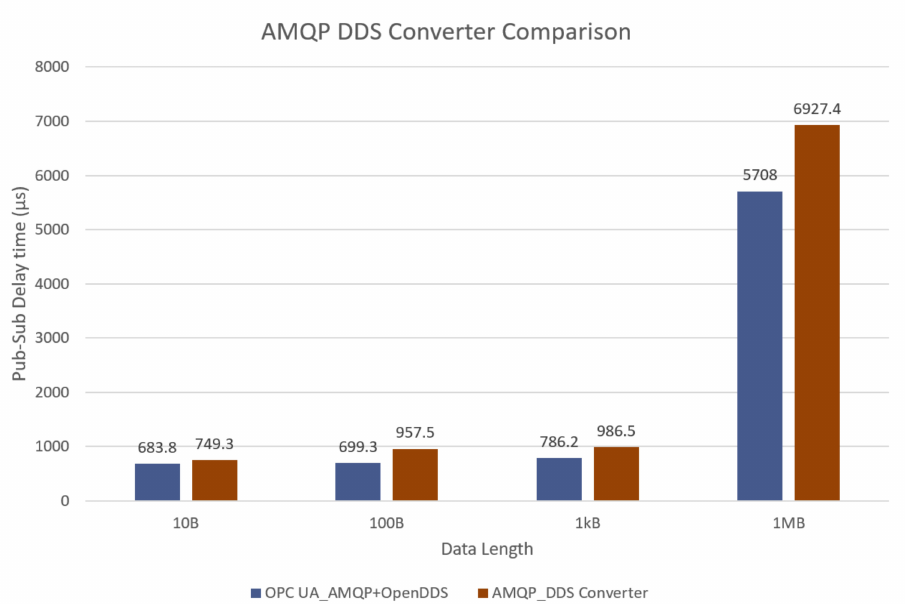
Figure 18. Comparison of latencies with and without the AMQP-based converter.